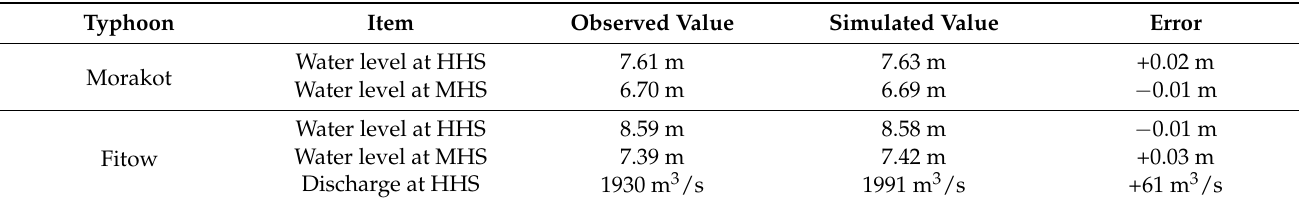
Table 1. Verification results of coupled